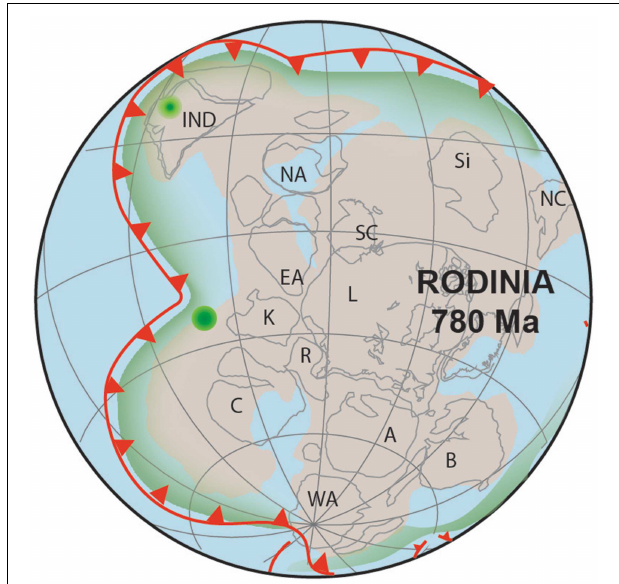
FIGURE 2 | Rodinia paleogeography model around 780 Ma (adapted and modified from Li et al. 2013 and using Paleomac software, Cogne, 2003 ). In red is the extension of presumed subductions around the supercontinent. Green zones highlight the suspected hot and oxidized magma zone under subductions. Green dots represent indian (ind) and arabic (soc) highly oxidized rocks related to subductions. Craton/terrane names abbreviations: IND, India; A, Amazonia; Si, Siberia; SC, South China; NA, Northern Australia; EA, East Antarctica; L, Laurentia; K, Kalahari; R, Rio de Plata; C, Congo; B, Baltica; WA, West-Africa; NC, North